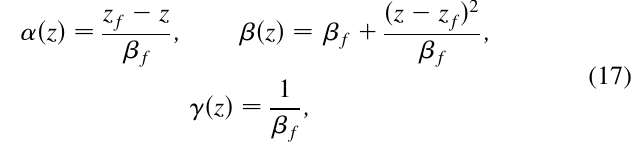
FIG. 3. Evolution of the normalized emittance (cid:1) simulations for the three considered cases. Arrows show the analytic predictions of the emittance growth. The betatron- decoherence length for the injection phase in the simulations (cid:5) 0 ¼ 1 : 00 relative to position z 0 is indicated by the dash- k p dotted line.